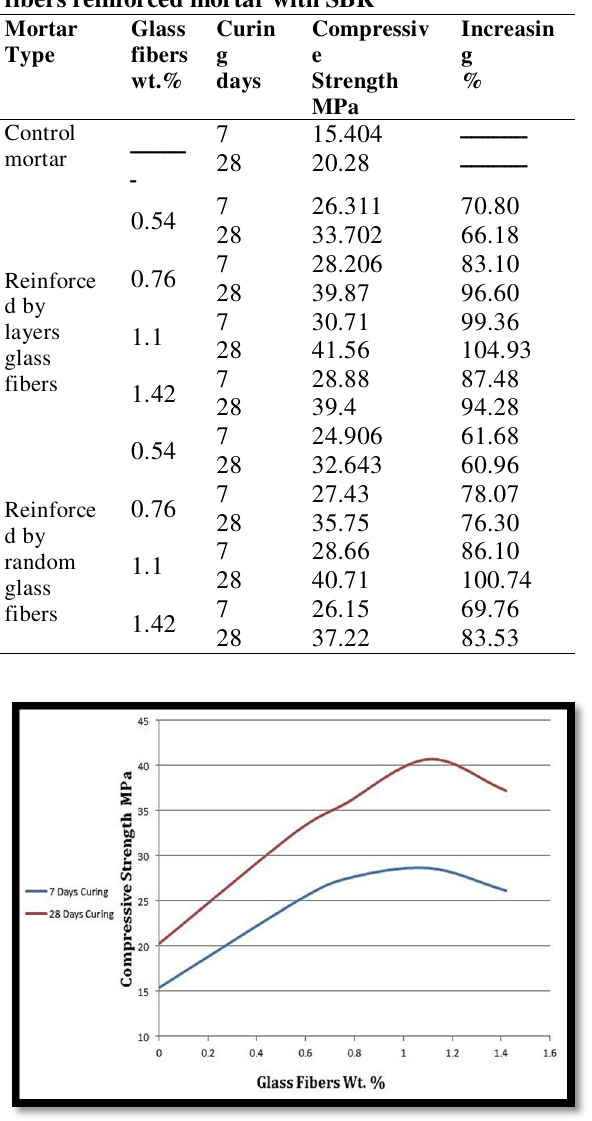
Fig. 10. Effect of random glass fibers addition with SBR to mortar after curing for 7 and 28 days.